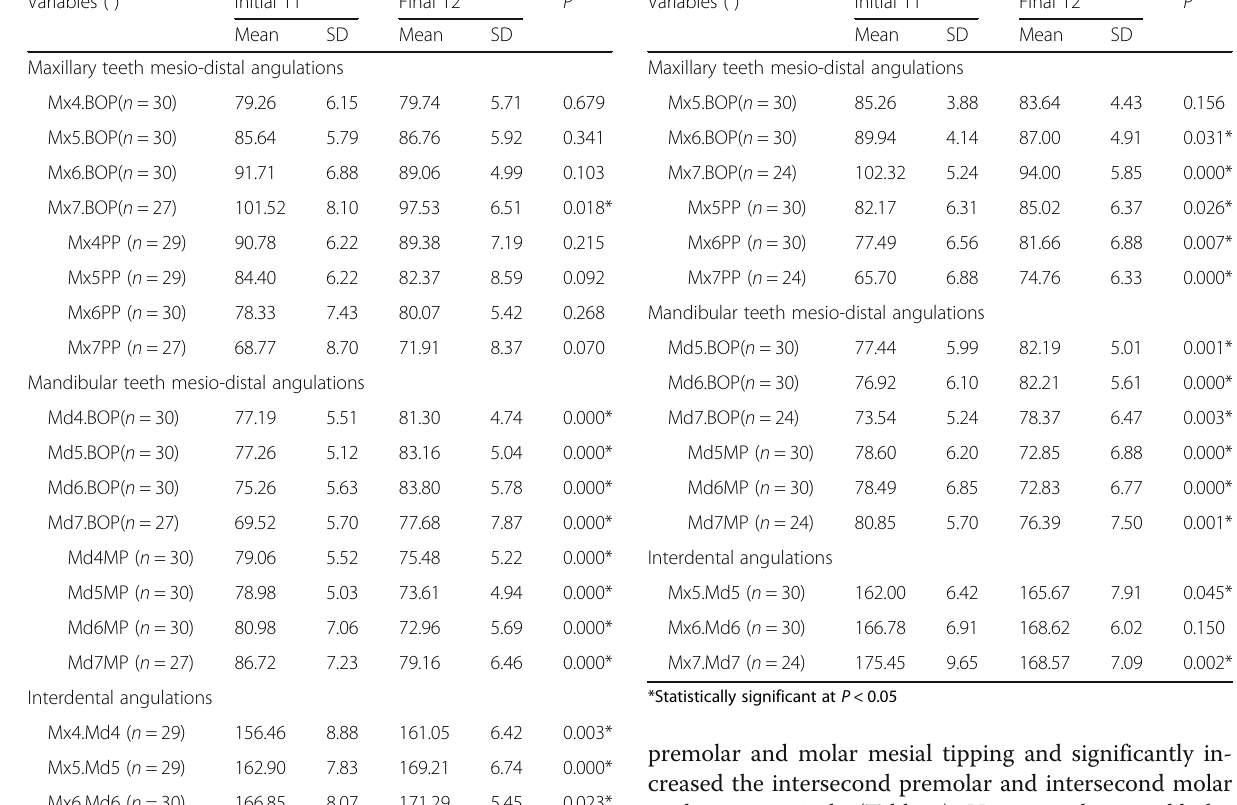
Maxillary teeth mesio-distal